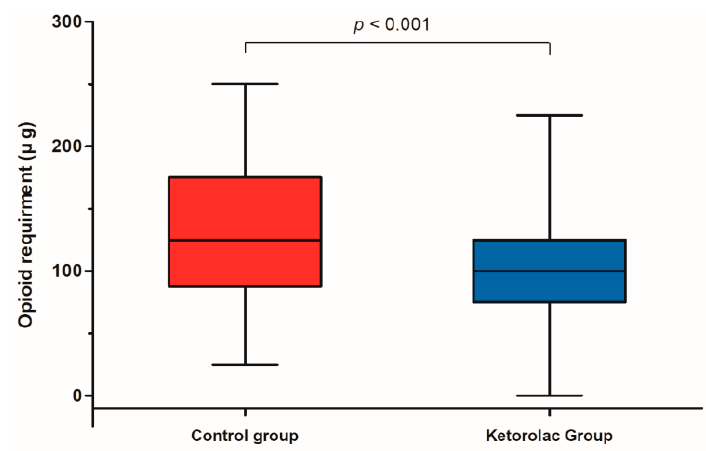
Figure 3. Comparison of opioid requirements within 24 h after surgery between the control group (red box) and ketorolac group (blue box). The line inside the rectangle shows the median. The upper and lower ends of the box indicate the third quartile and first quartile, respectively. Whiskers above and below the box designate 90% and 10%, respectively. Table 3. Postoperative pain score, opioid requirement, ketorolac-related complications, patient satisfaction score, and hospitalization duration in patients undergoing robot-assisted laparoscopic radical prostatectomy.